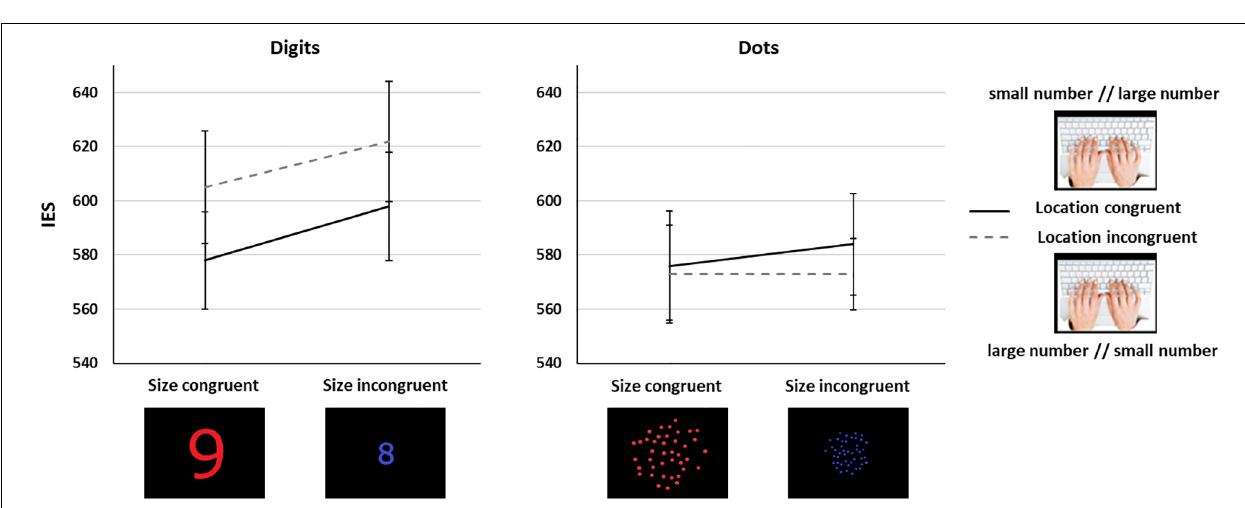
FIGURE 2 | Illustration of the methodology used in Experiment 1 (Numerical comparison task) and Experiment 2 (Color classification task).